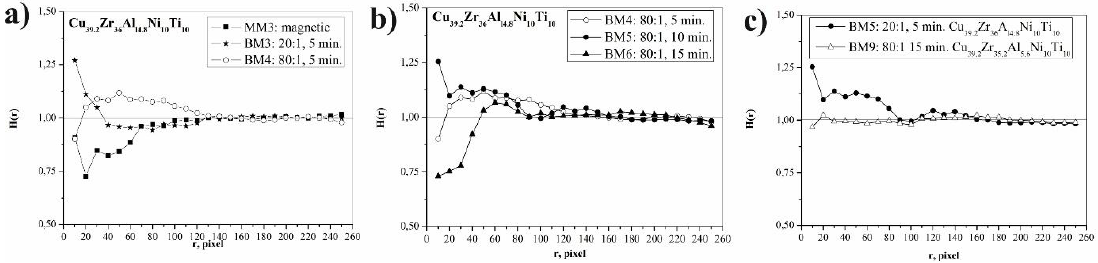
Figure 5. RDF curves of compacted samples with different mixing techniques.